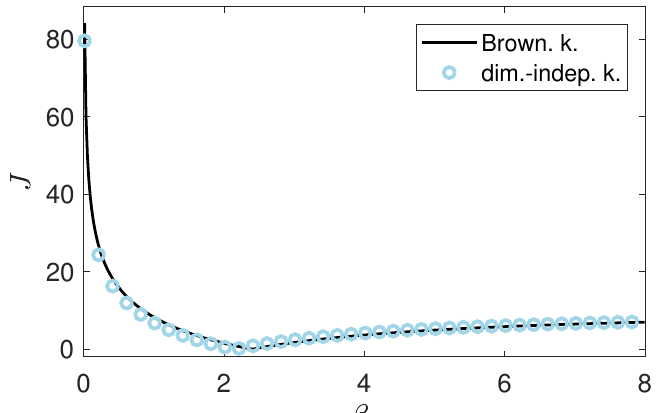
Figure 7. Profile likelihoods for the Brownian motion and volume-independent kernel.